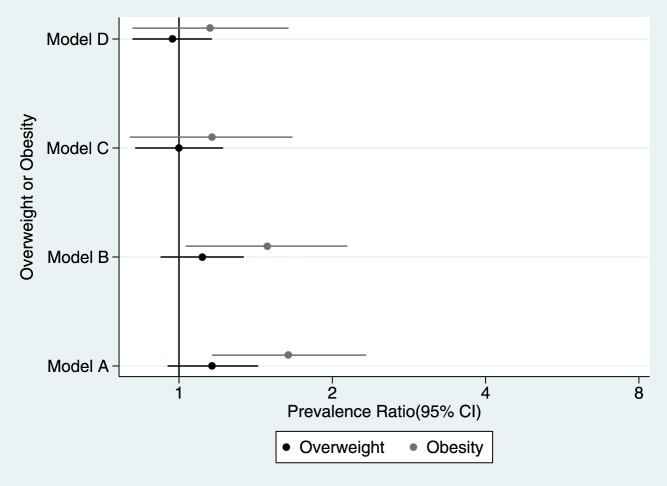
Prevalence ratio of overweight and obesity.Young Lives Study, 3° round younger cohort. Model A: crude exposure-outcome estimation. Model B: only adjusted for age, birth weight, total meals previous day and physical activity. Model C: only adjusted for maternal education, paternal education, maternal weight, location and wealth index. Model D: adjusted for all the co-variables.